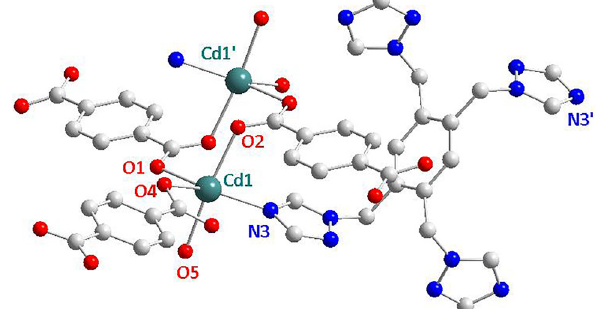
Table  : Data collection and